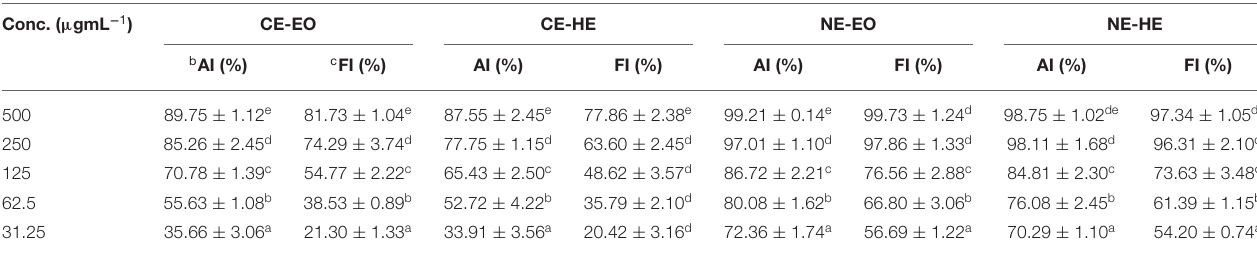
TABLE 6 | Evaluation a of CEs and NEs of EO and HE of P. cablin for determination of antifeedant index (AI) and feeding index (FI) after